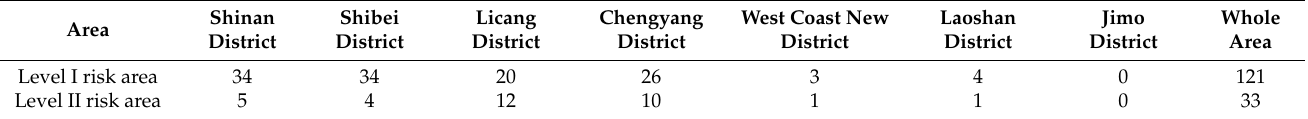
Figure 13. Distribution map of high-risk epidemic sites. Table 6. Distribution of high-risk areas in seven municipal districts of